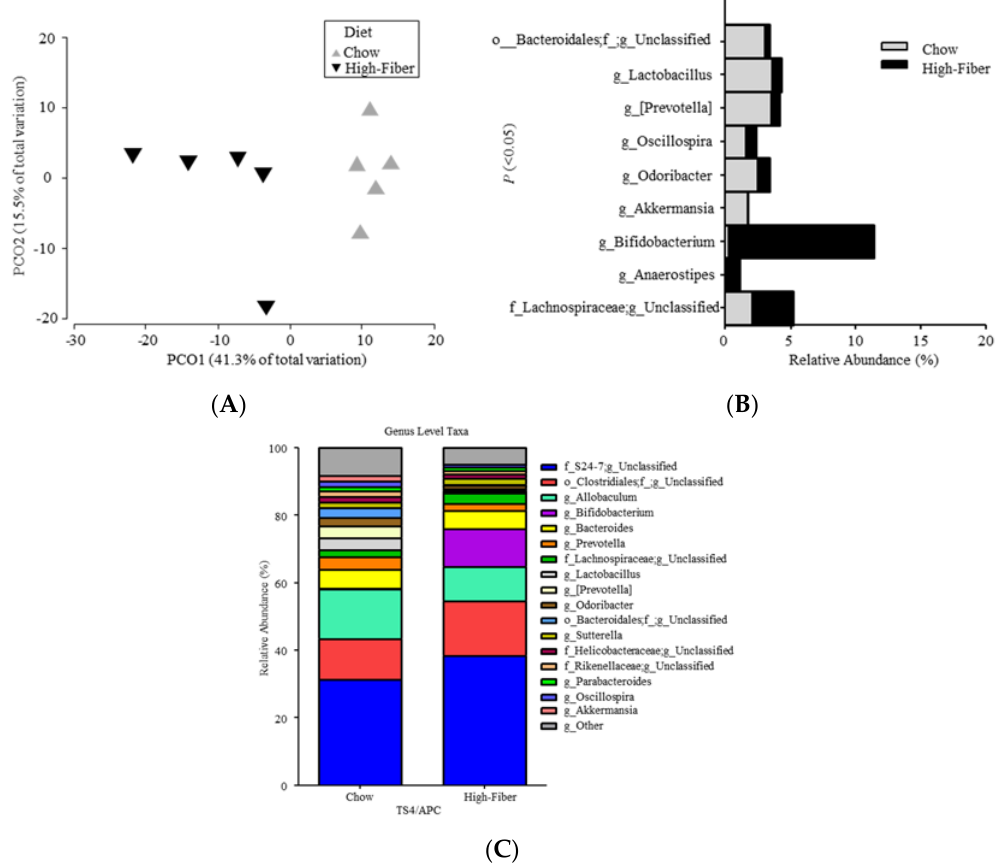
Figure 4. ( A–C ) Significantly different microbial profiles between TS4/APC chow-fed and high fiber-fed mice feces: ( A ) Principal coordinate analysis (PCoA) profile of microbial diversity (genus) across all samples, with the percentage of variation explained by PC1 and PC2 indicated in the axis; ( B ) Stacked bars of significantly different ( p ˂ 0.05) rarefied sequences of microbial taxa (relative abundance percentages of total bacteria at genus) between mice groups; ( C ) Stacked histograms depicting 90% of the rarefied sequences of microbial taxa (relative abundance percentages of total bacteria at the genus) between mice groups.